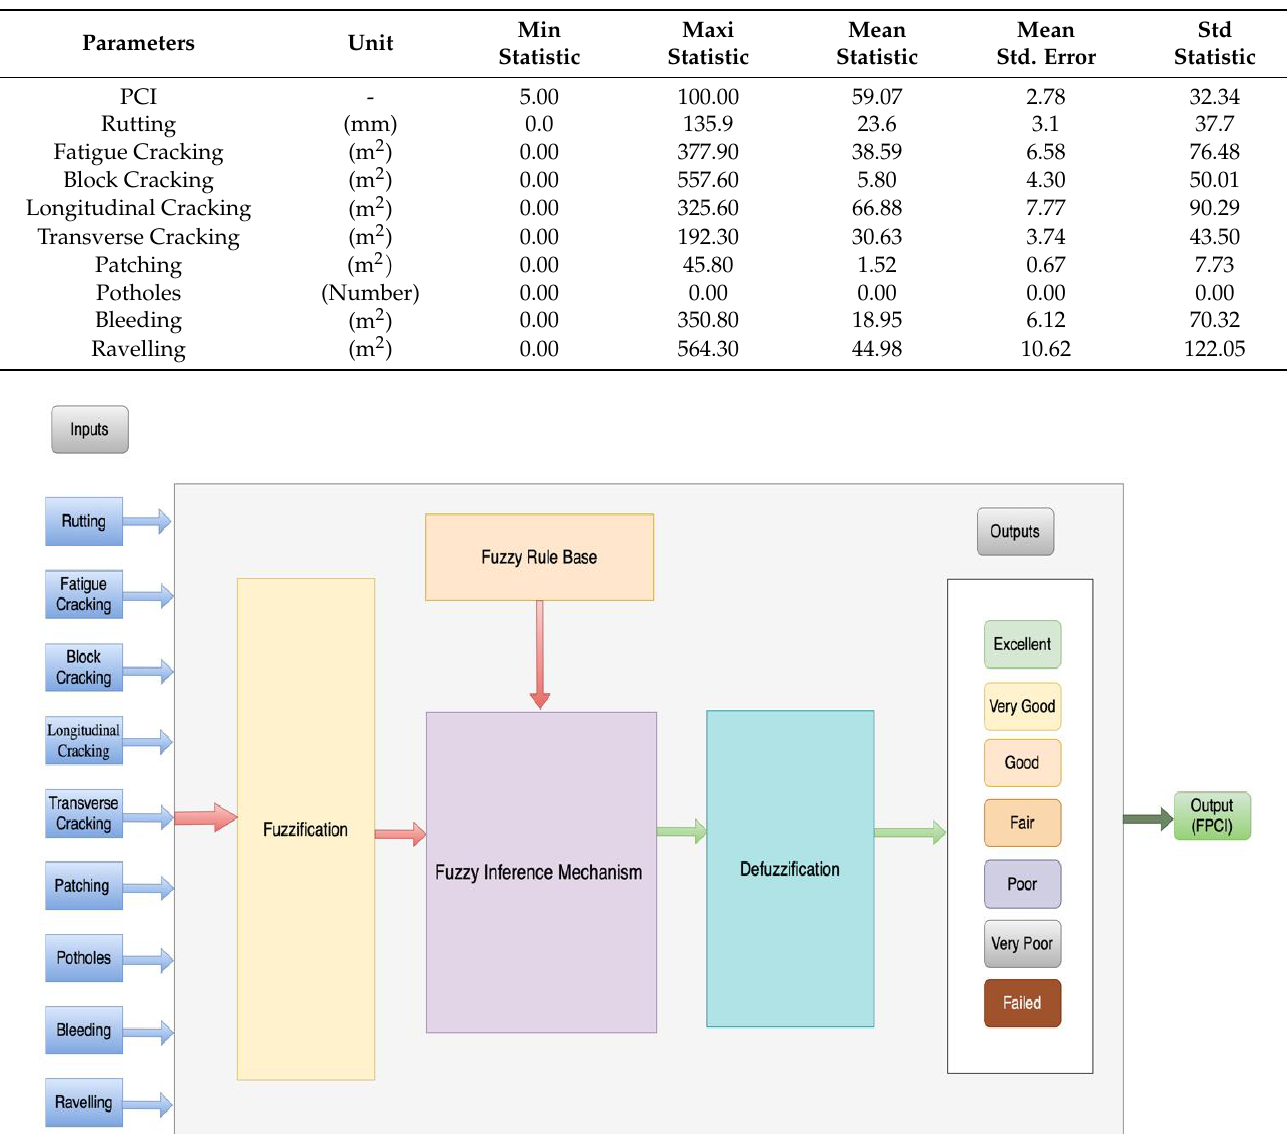
Table 1. Descriptive statistics for 120 and 150 sections of the measured deterioration.